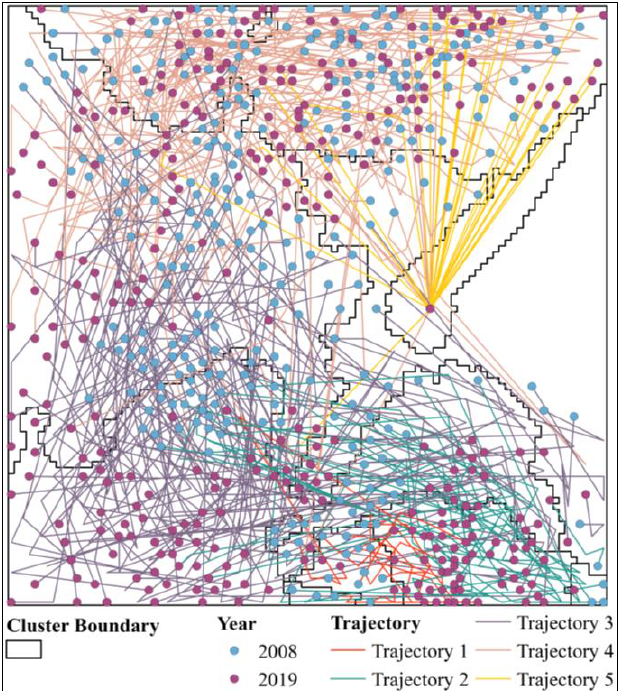
Figure 8. Clustering results of node change trajectory.